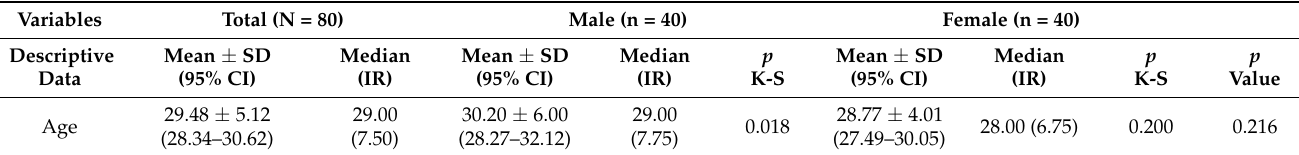
Table 1. Age of the participants by sex